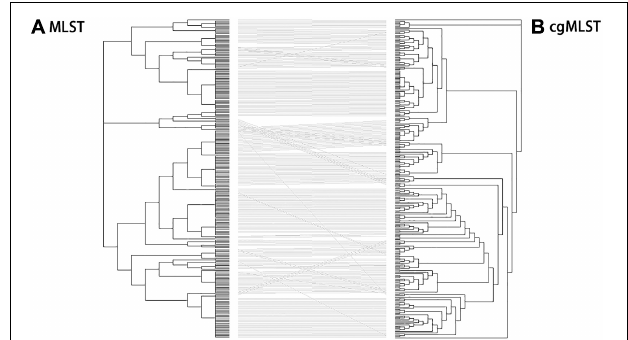
FIGURE 6 | Comparison of phylogenies by MLST (A) and cgMLST (B) based on genomic sequences of 250 Salmonella isolates. Tanglegram linking tips with the same label to each other via a straight line produced within dendroscope 3 of 250 Salmonella isolates. By comparing of N-J trees by MLST and cgMLST, clustering in the two trees was mostly congruent although a few sections show several inversions. This led to some isolates being clustered at the edge of one tree, moving to the center of the other. In addition, the tree by cgMLST was more detailed than that by